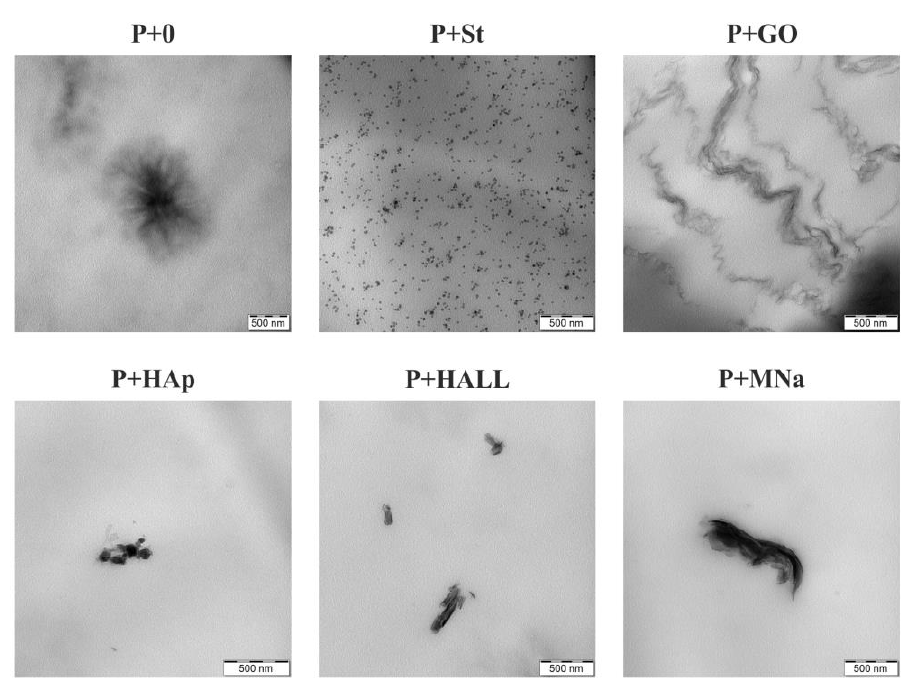
Figure 7. Transmission electron microscopy (TEM) images of the neat PUU matrix (P+0) and selected PUU nanocomposites.